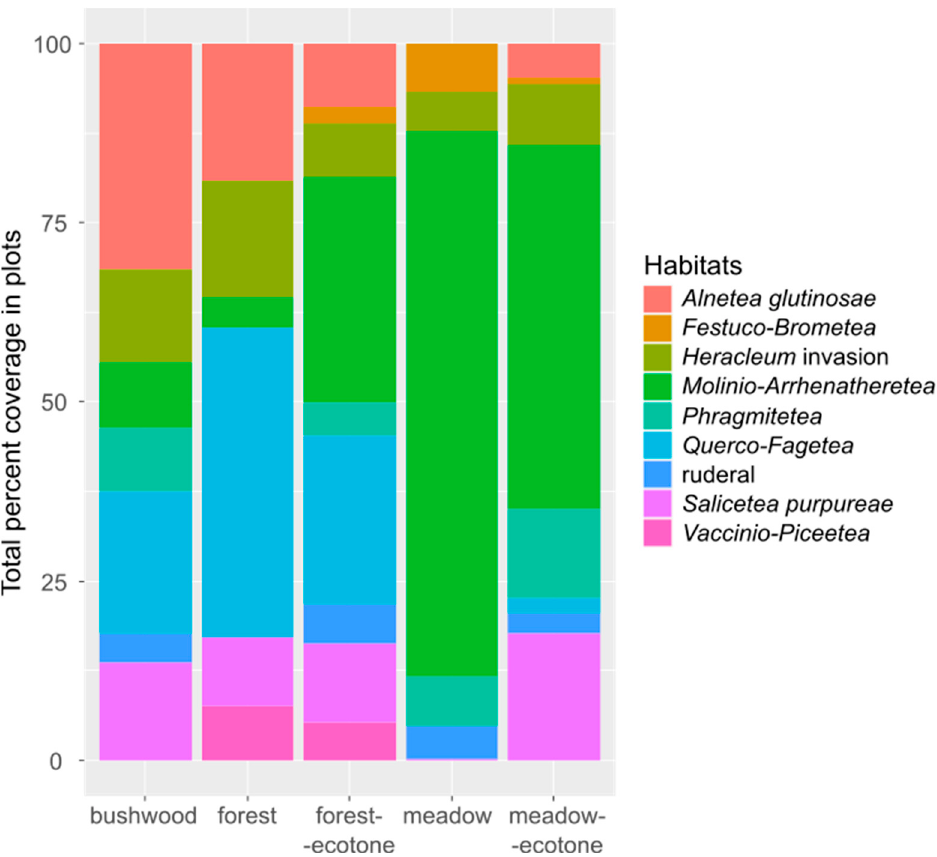
Figure 4. Total percent coverage of various plant communities on 50 m radius plots classified into five categories (bushwood, forest, forest ecotone, meadow, meadow ecotone).